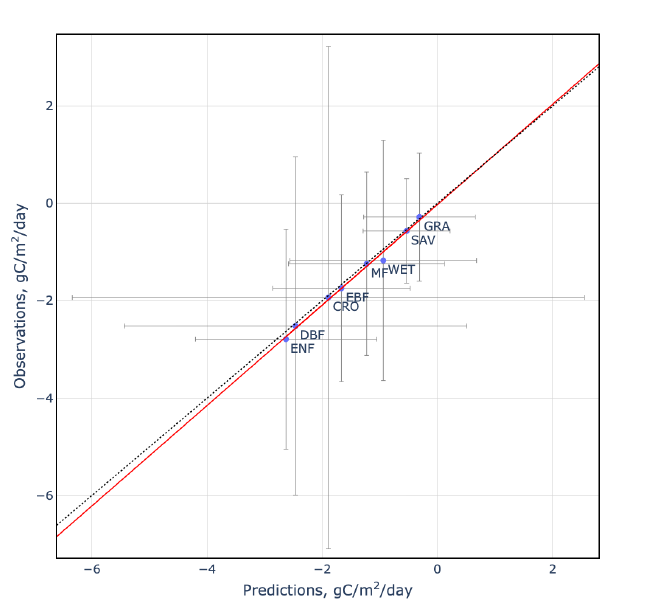
Figure 6. Comparison of observed and predicted mean NEE for different land covers in this study. Error bars of each land cover are the standard deviation of observed and predicted daily